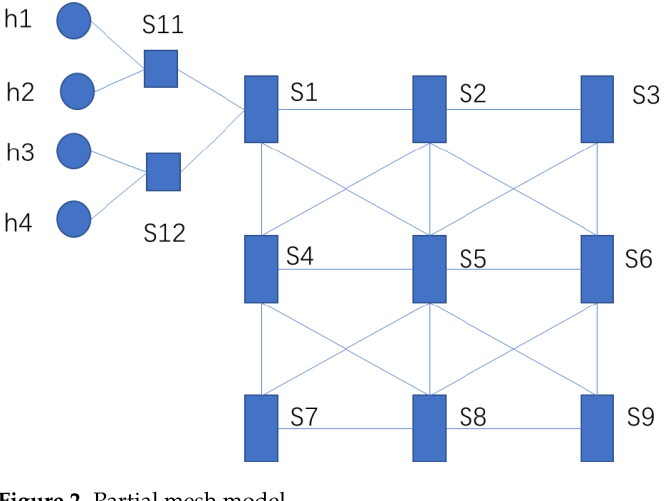
Figure 2. Partial mesh model.